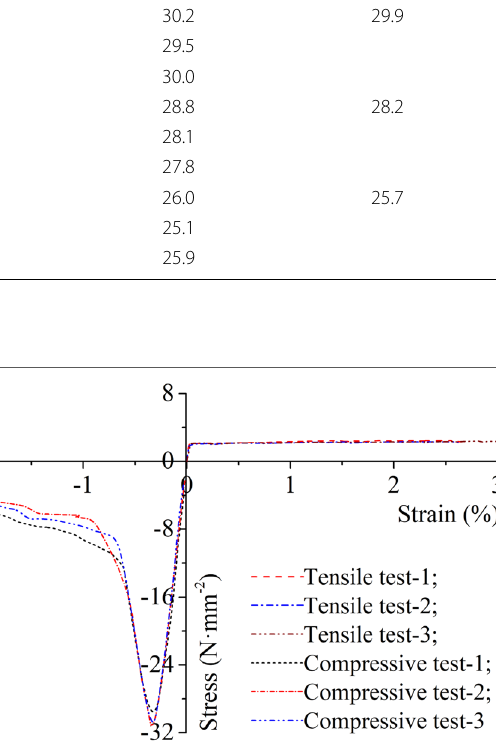
Figure 3 (taking group BC for example) presents the cross-section average strain distributions at various loads, Fig. 3a–d for 0, 50, 100 and 150 freeze–thaw cycles, respectively.